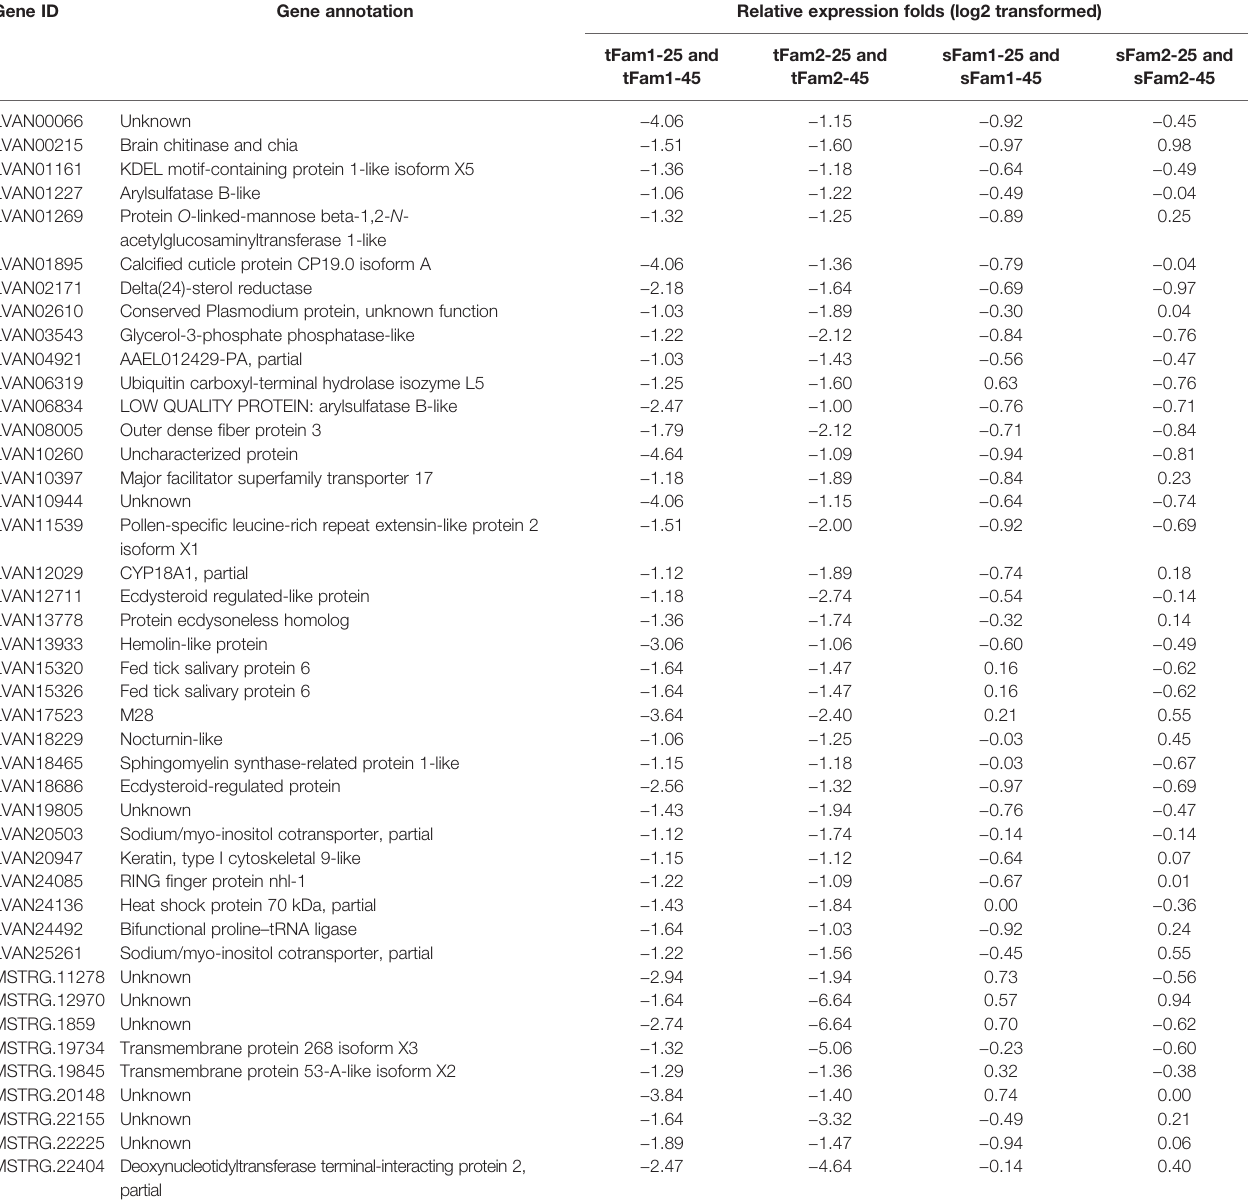
TABLE 4 | Genes downregulated signi fi cantly in tolerant families but not signi fi cant in susceptible families under high-salinity